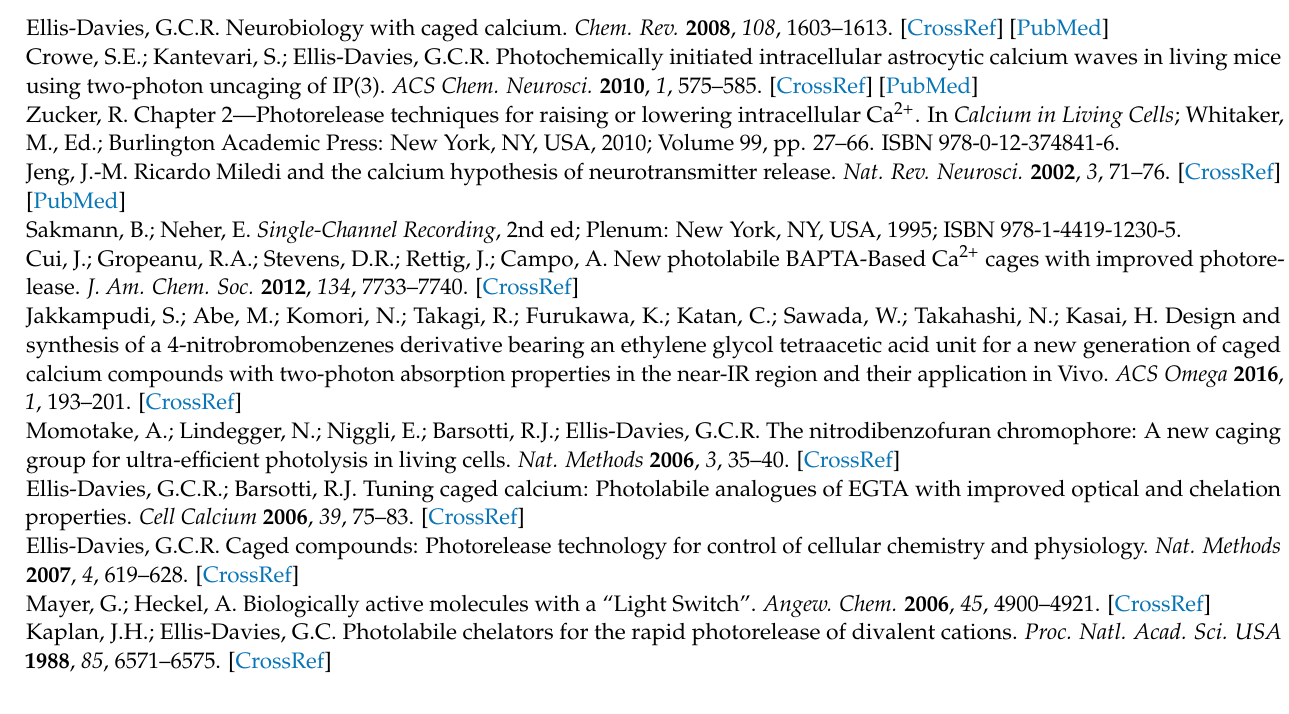
Figure S2: 1 H NMR spectrum of compound 4 ; Figure S3: 1 H NMR spectrum of compound 5 ; Figure S4: 1 H NMR spectrum of compound 6 ; Figure S5: 1 H NMR spectrum of compound 6a ; Figure S6: 1 H NMR spectrum of compound 7 ; Figure S7: 1 H NMR spectrum of compound 9 ; Figure S8: 1 H NMR spectrum of compound 10 ; Figure S9: 1 H NMR spectrum of compound 11 ; Figure S10: 1 H NMR spectrum of compound 12 ; Figure S11: 1 H NMR spectrum of compound 13 ; Figure S12: 1 H NMR spectrum of compound 14 ; Figure S13: 1 H NMR spectrum of compound 15 ; Figure S14: 1 H NMR spectrum of compound 16 ; Figure S15: 1 H NMR spectrum of compound 17 ; Figure S16: 1 H NMR spectrum of compound 18 ; Figure S17: 1 H NMR spectrum of compound 18a ; Figure S18: 1 H NMR spectrum of compound 19 ; Figure S19: 1 H NMR spectrum of compound 21 ; Figure S20: 1 H NMR spectrum of compound 23 ; Figure S21: 1 H NMR spectrum of compound 24